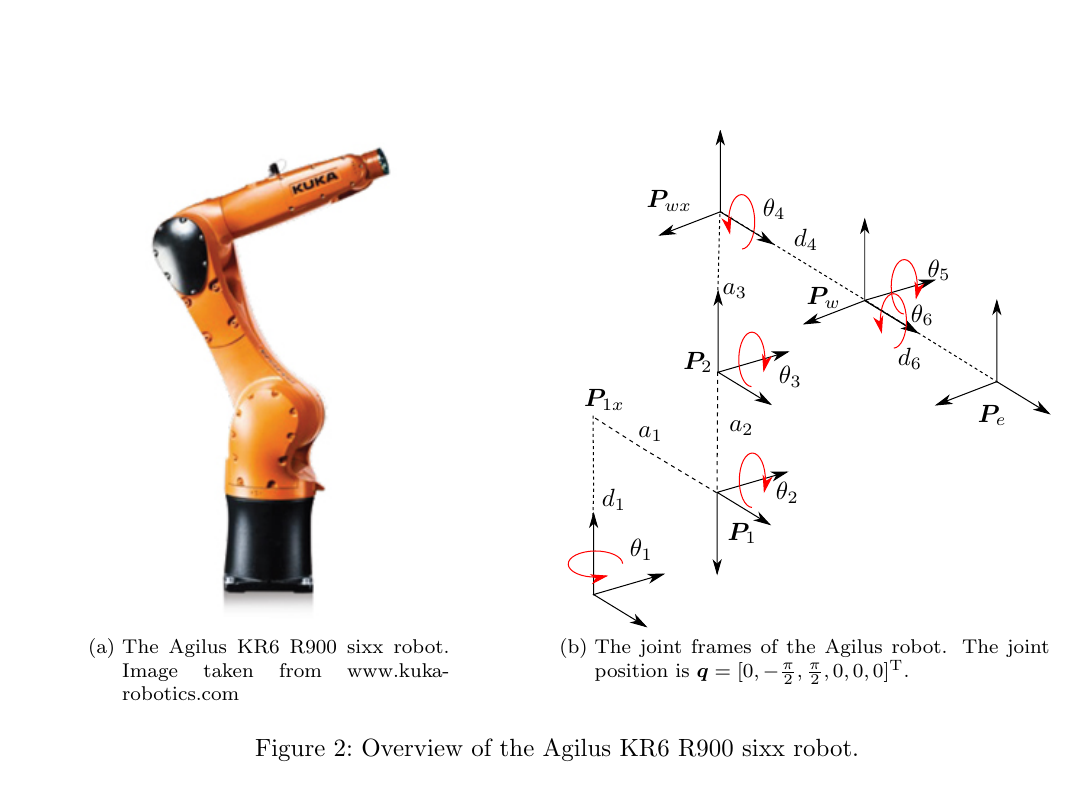
Figure 2: Overview of the Agilus KR6 R900 sixx robot.